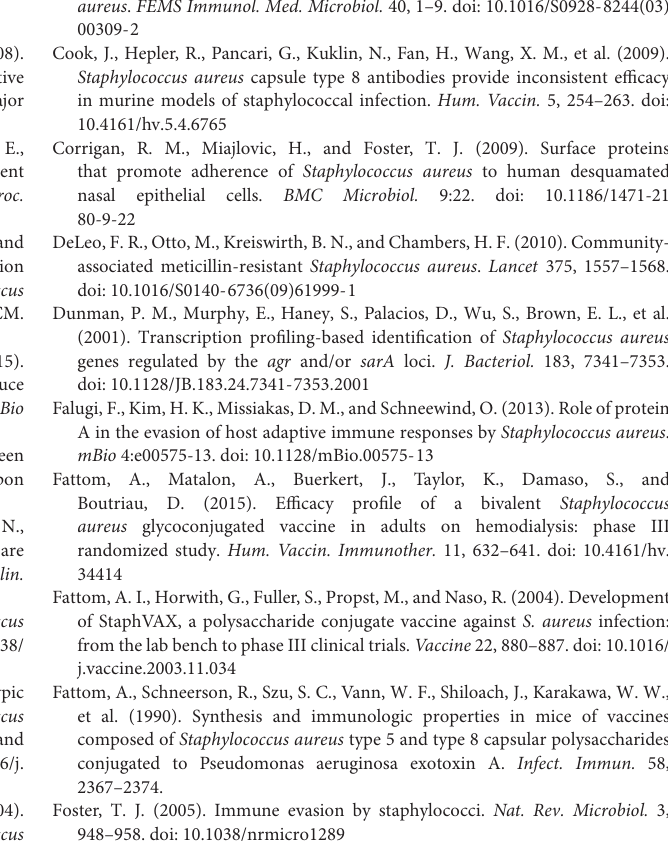
FIGURE S1 | Kinetic profiles of the four major transcription clusters. Black lines represent the mean values of single genes and the error bars show the standard deviation among the isolates. The mean profile of the genes within the cluster is showed in pink. In cluster 4, the blue line represents the mean of the cluster in N315 strain. FIGURE S2 | spa transcript profiles in all the SpA + and SpA − strains. The black lines indicate the transcript profile of the SpA + strains, while the colored ones represent the spa RNA levels in the SpA − strains. All the values are normalized to the mean of the SpA + strains in the early exponential phase. The three strains that carry the RBS mutation are highlighted in the figure legend. FIGURE S3 | Lack of capsule-mediated opsonophagocytosis in N315 background is not due to anti-phagocytic activity of SpA. The graph shows the fluorescence associated to neutrophils after phagocytosis of fluorescent stained bacteria, under different conditions. The phagocytosis was performed in absence of both serum and complement (–S –C), in absence of complement and in presence of different serum dilutions (S –C), in absence of serum and in presence of inactivated complement (IC), in absence of serum and in presence of complement (–S + C), or in presence of both complement and different dilutions of serum (S + C). Each experiment was normalized by the corresponding –S –C sample. The experiment was performed in triplicate, the error bars show the standard deviations. TABLE S1 | Strains used in this study. TABLE S2 | Plasmids used in this study. TABLE S3 | Oligonucleotides used in this study. TABLE S4 | TaqMan assays used in this